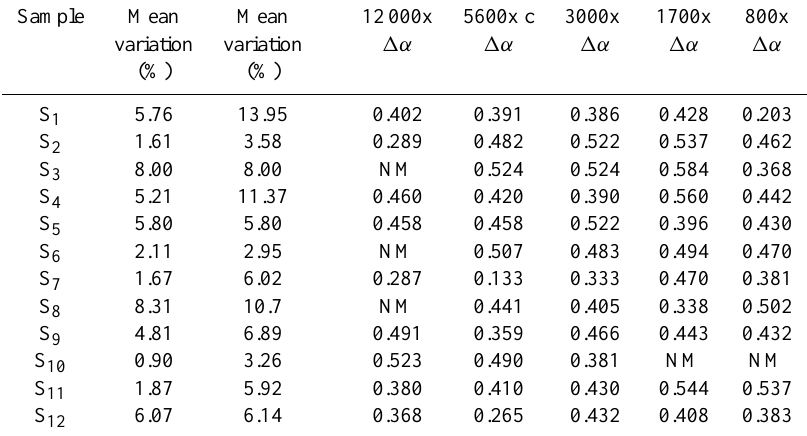
Figure 12. Sample S acquired at five magnifications: 12000x (M Fig. 12. Sample S 1 acquired at five magnifications: 12000x (M 1 ) , 5600x (M 2 ) , 3000x (M 3 ) , 1700x (M 4 ) and 800x (M 5 ) . 1 1700x (M ) and 800x (M ). 3 4 5 Table 2. The mean of multifractal dimensions variations, for q ≥ 0, for all samples and the variation of the factor α . The first column shows samples names. The second shows the mean of variations for intermediate magnifications only (magnifications 1700x to 12000x). The third column provides the mean of variations including the lower magnification (800x). The following columns recapitulate the variation of the factor α for the five magnifications for each sample. (NM: Non